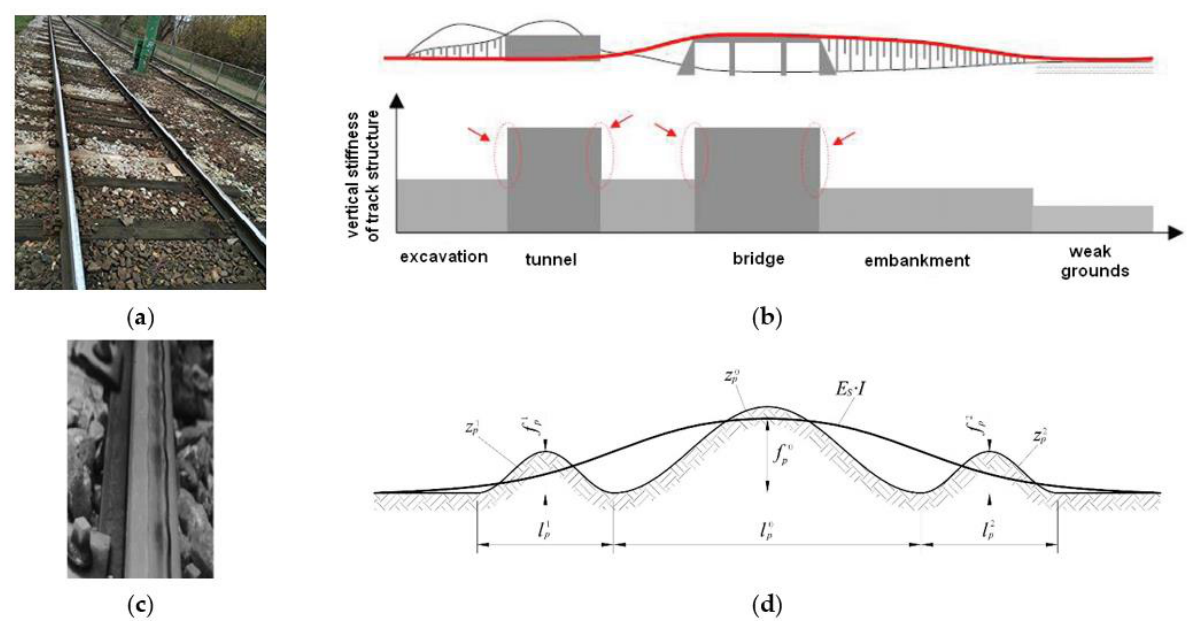
Figure 1. Typical examples of imperfections arising in a railway track: ( a ) an irregularity (in consequence of a change in sleeper types); ( b ) variable support of the track structure along the railway track; ( c ) a rail corrugation [16]; ( d ) triple irregularities in the track (an example).